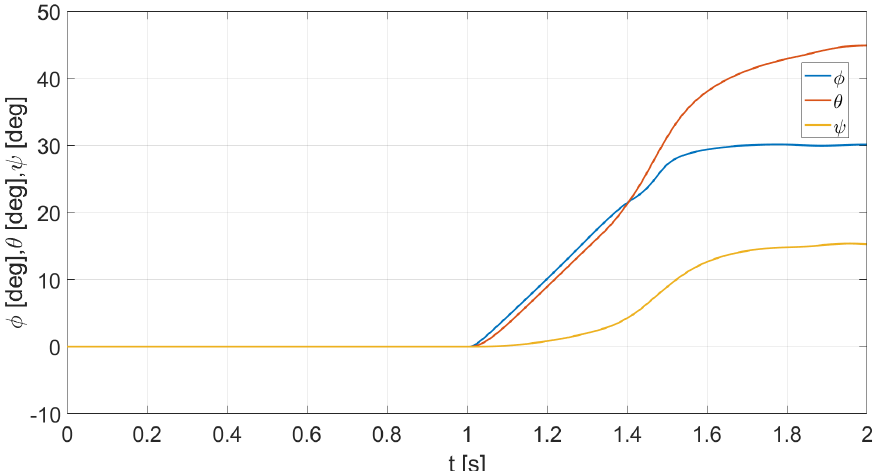
Figure 9. Angular response of the UAV—PID-SDRE control mode, t f = 1